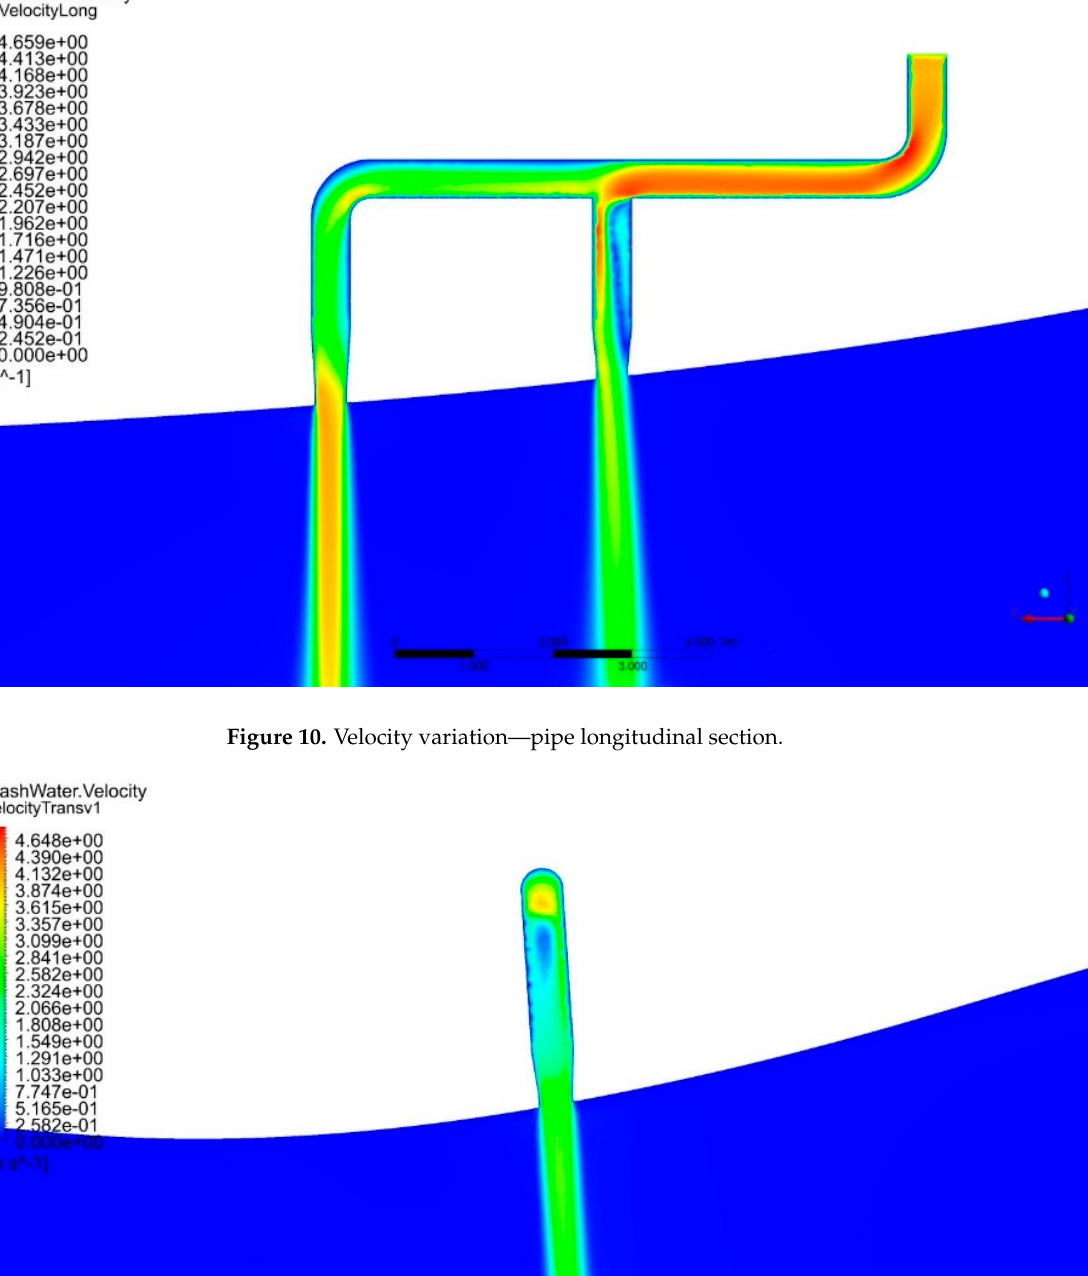
Figure 9. RMS residuals for k and ε values (initial mesh).